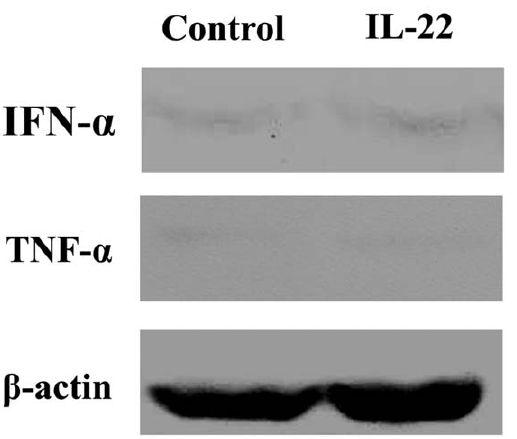
Figure 2. Expression of IFN- a and TNF- a in A498 xenografts after rIL-22 treatment. Western blot assay was performed to detect the expression of IFN- a and TNF- a in the A498 cell xenografts. Neither the expression of IFN- a nor TNF- a were increased significantly in A498 cell xenografts treated with rIL-22 (P . 0.05 compared with control). N=2.